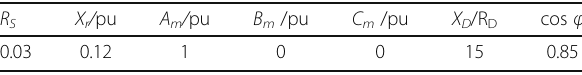
Table 3 Typical value of non-key